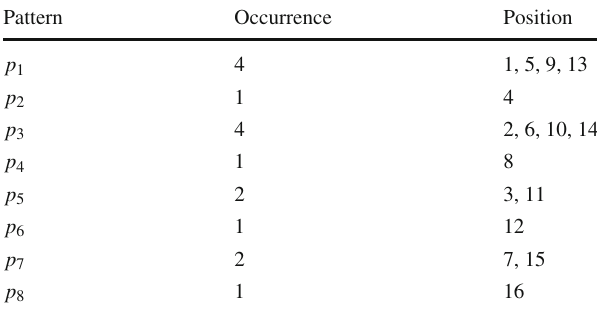
Table 2 Example of the resulting set